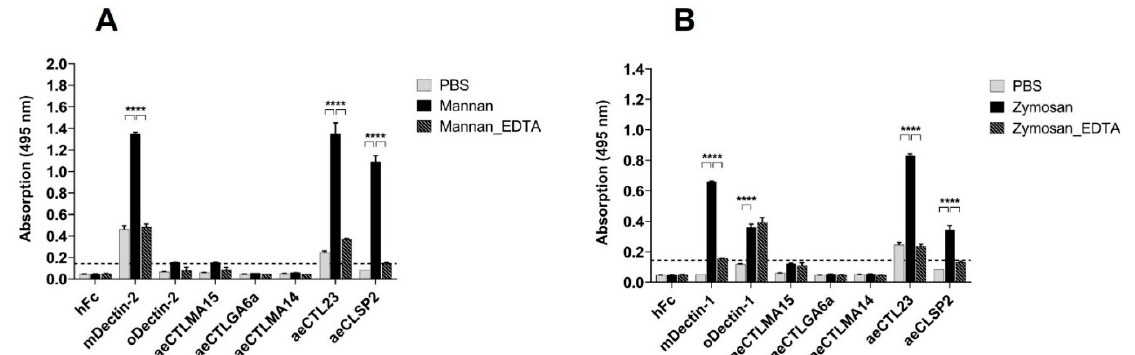
Figure 4. Mosquito CLR–hFc fusion protein interaction to mannan and zymosan: ( A ) ELISA-based screening of mannan with five mosquito CLR–hFc fusion proteins, in the presence and absence of EDTA. mDectin-2/oDectin-2 are known to recognise mannan (positive control) [35,41] and hFc-empty employed as negative control. One representative of n = 4 (EDTA n = 2) independent experiments shown; ( B ) ELISA-based screening of zymosan with five mosquito CLR–hFc fusion proteins, in the presence and absence of EDTA. mDectin-1/oDectin-1 are known to recognise zymosan (positive control) [35,43] and hFc-empty employed as negative control; ( A , B ) to discard possible false positives, the dotted line represents the cutoff defined as the threefold margin of the absorbance value relative to hFc, based on previous screenings with the CLR–hFc fusion protein library [34,46]. Data are depicted as mean + SEM of duplicates. One representative of n = 4 (EDTA n = 2) independent experiments is shown. One-way ANOVA, along with subsequent pairwise Tukey tests, was performed to compare the binding of the CLR–hFc fusion proteins above the threshold to PBS control and the EDTA supplementation each; **** p < 0.0001.